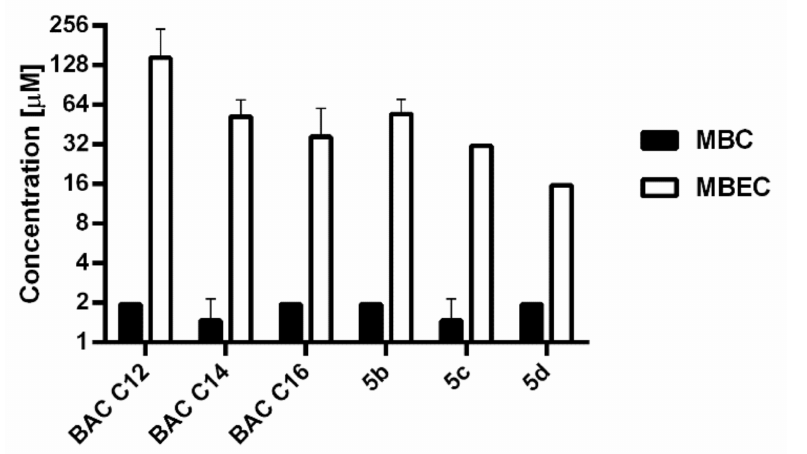
Figure 6. MBEC values and MBC values established for S. aureus. MBC and MBEC values were determined after 24 h of incubation for BAC and 5b-d series by broth microdilution method and MBEC assay respectively. Results are expressed as the mean ± SD ( n =